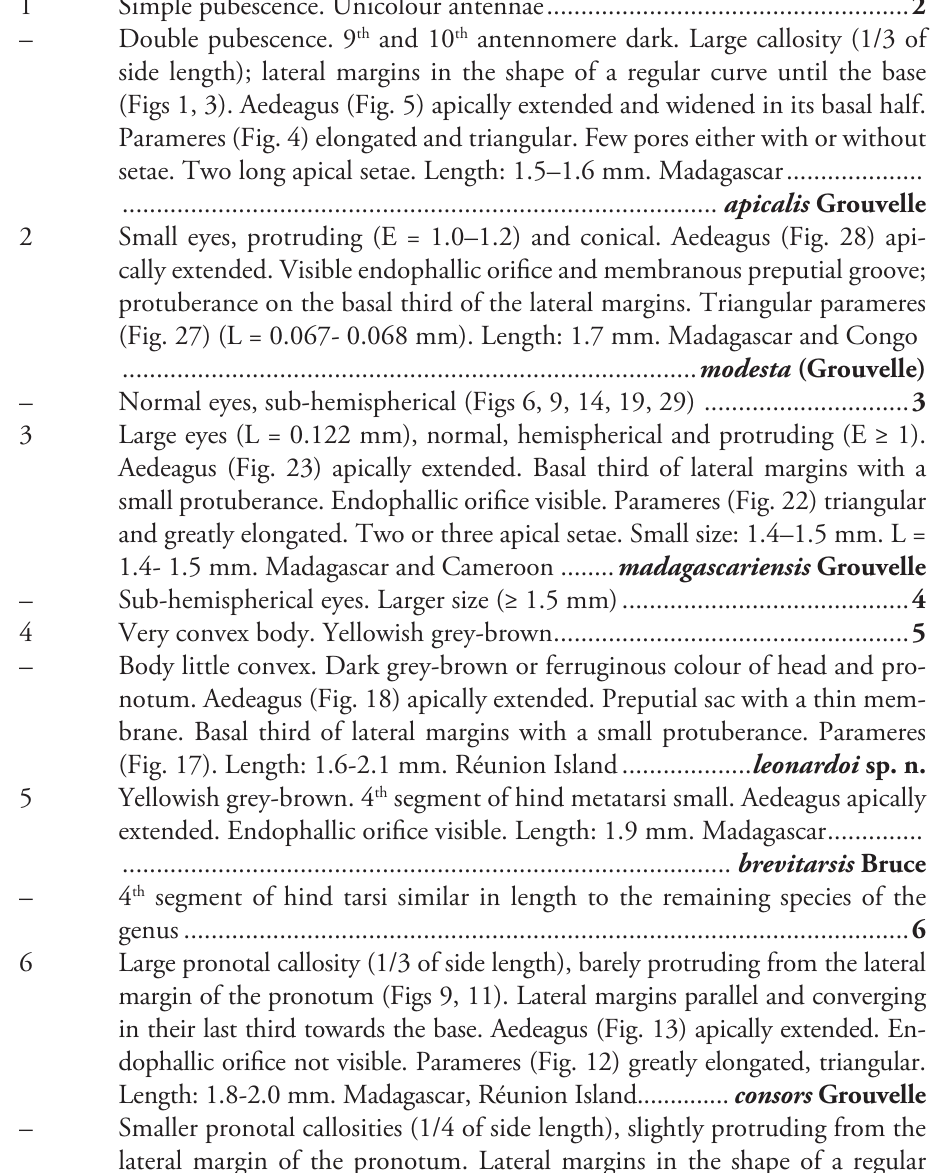
Simple pubescence. Unicolour antennae ..................................................... 2 – Double pubescence. 9 th and 10 th antennomere dark. Large callosity (1/3 of side length); lateral margins in the shape of a regular curve until the base (Figs 1, 3). Aedeagus (Fig. 5) apically extended and widened in its basal half. Parameres (Fig. 4) elongated and triangular. Few pores either with or without setae. Two long apical setae. Length: 1.5–1.6 mm. Madagascar .................... 2 Small eyes, protruding (E = 1.0–1.2) and conical. Aedeagus (Fig. 28) api- cally extended. Visible endophallic orifice and membranous preputial groove; protuberance on the basal third of the lateral margins. Triangular parameres (Fig. 27) (L = 0.067- 0.068 mm). Length: 1.7 mm. Madagascar and Congo .................................................................................... modesta (Grouvelle) – Normal eyes, sub-hemispherical (Figs 6, 9, 14, 19, 29) .............................. 3 3 Large eyes (L = 0.122 mm), normal, hemispherical and protruding (E ≥ 1). Aedeagus (Fig. 23) apically extended. Basal third of lateral margins with a small protuberance. Endophallic orifice visible. Parameres (Fig. 22) triangular and greatly elongated. Two or three apical setae. Small size: 1.4–1.5 mm. L = 1.4- 1.5 mm. Madagascar and Cameroon ........ madagascariensis Grouvelle – Sub-hemispherical eyes. Larger size (≥ 1.5 mm) .......................................... 4 4 Very convex body. Yellowish grey-brown .................................................... 5 – Body little convex. Dark grey-brown or ferruginous colour of head and pro- notum. Aedeagus (Fig. 18) apically extended. Preputial sac with a thin mem- brane. Basal third of lateral margins with a small protuberance. Parameres (Fig. 17). Length: 1.6-2.1 mm. Réunion Island ................... leonardoi sp. n. 5 Yellowish grey-brown. 4 th segment of hind metatarsi small. Aedeagus apically extended. Endophallic orifice visible. Length: 1.9 mm. Madagascar .............. – 4 th segment of hind tarsi similar in length to the remaining species of the genus .......................................................................................................... 6 6 Large pronotal callosity (1/3 of side length), barely protruding from the lateral margin of the pronotum (Figs 9, 11). Lateral margins parallel and converging in their last third towards the base. Aedeagus (Fig. 13) apically extended. En- dophallic orifice not visible. Parameres (Fig. 12) greatly elongated, triangular. Length: 1.8-2.0 mm. Madagascar, Réunion Island.............. consors Grouvelle – Smaller pronotal callosities (1/4 of side length), slightly protruding from the lateral margin of the pronotum. Lateral margins in the shape of a regular curve from the callosity to the base (Figs 29, 31). Aedeagus (Fig. 33). Para- meres (Fig. 32) elongated and dilated on the base. Length: 1.5-1.9 mm.